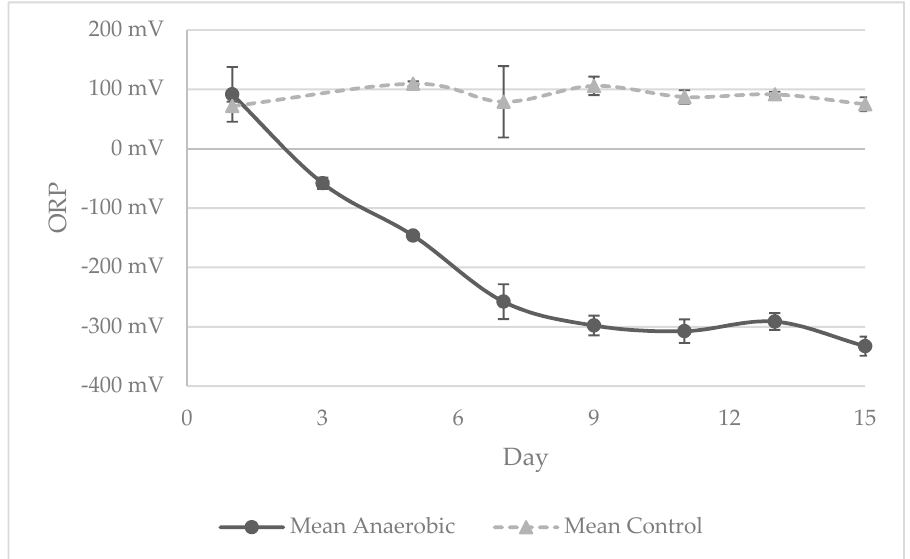
Figure 3. Reactor ORP. Mean ORP within the control (dash line) and anaerobic (solid line) replicates throughout the 15-day study period. Error bars indicate standard deviation between treatment replicates.